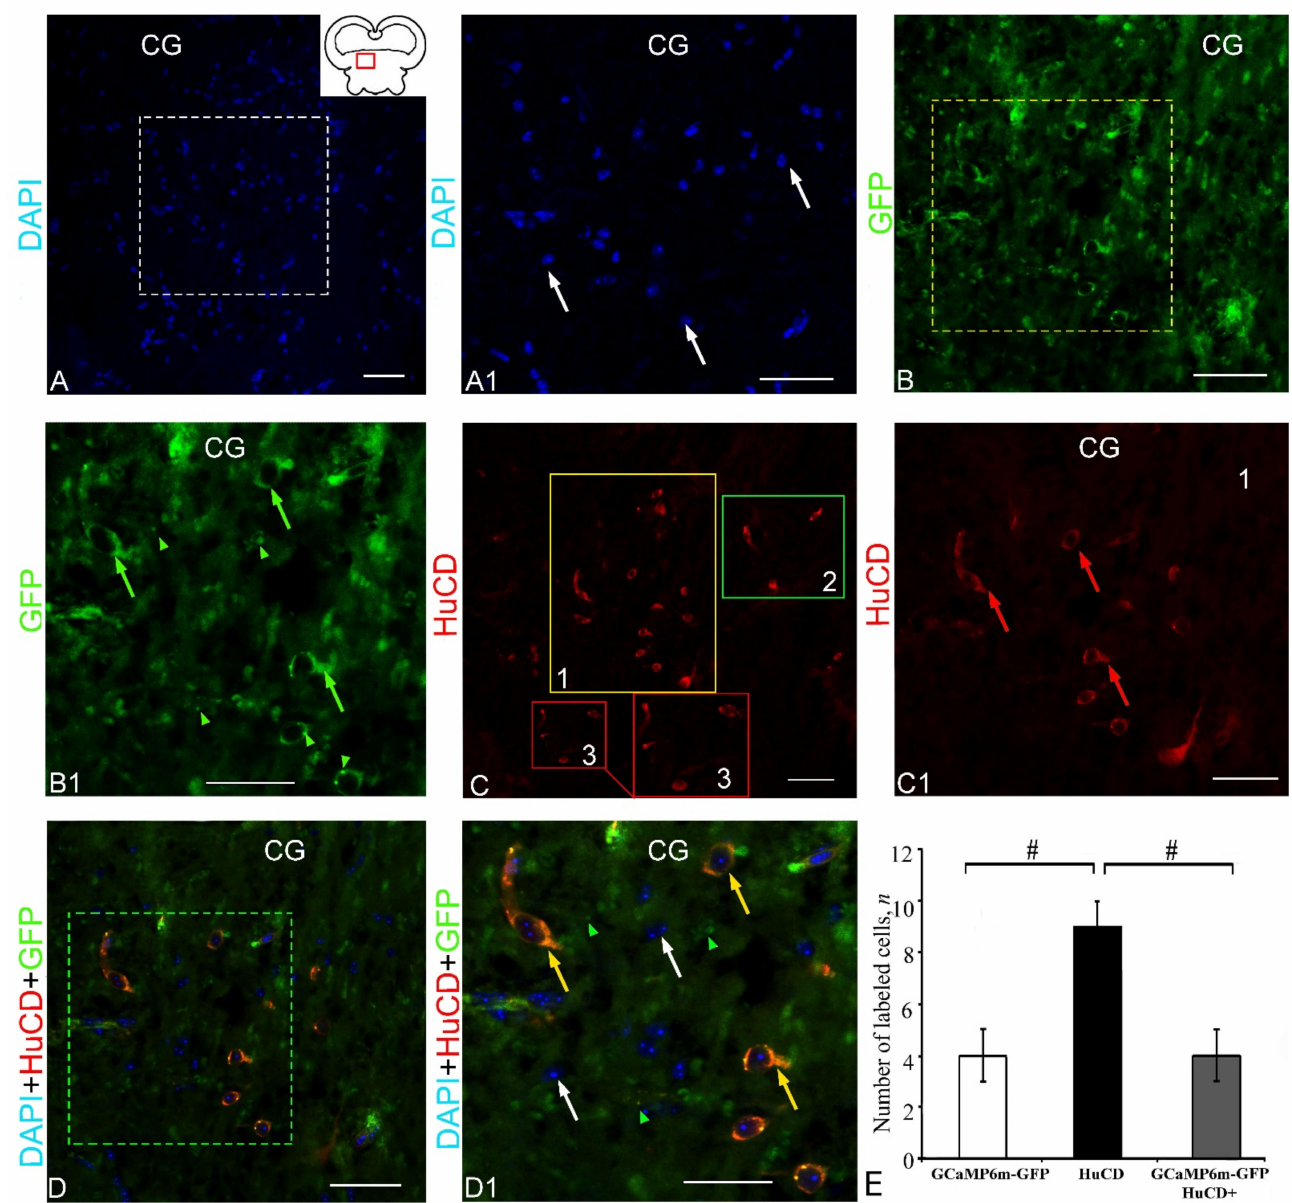
Figure 12. Z-stacks showing DAPI staining, localization of green fluorescent protein GFP and HuCD, and their co-localization in the corpus geniculatum of juvenile chum salmon, O. keta , at 90 days after a single injection of the rAAV into the cerebellar ody. ( A ) DAPI staining with a pictogram showing the geniculate region (in a red box); the white box outlines a cluster of DAPI-stained nuclei; CG, corpus geniculatum . ( A1 ) The enlarged fragment outlined by a white dotted box in A; DAPI-stained heteromorphic nuclei with nucleoli (white arrows). ( B ) Expression of green fluorescent protein GFP in geniculate cells (in dotted box). ( B1 ) The enlarged fragment outlined by a yellow dotted box in B; GFP+ cells (green arrows) and GFP+ granules (green arrowheads). ( C ) Immunofluorescence of the HuCD protein in populations (1–3) of geniculate neurons. For population 3, the inset shows an enlarged fragment. ( C1 ) The enlarged fragment outlined by a yellow box in C; HuCD+ neurons (red arrows). ( D ) Optical overlay of three DAPI/GFP/HuCD staining channels showing areas of GFP/HuCD